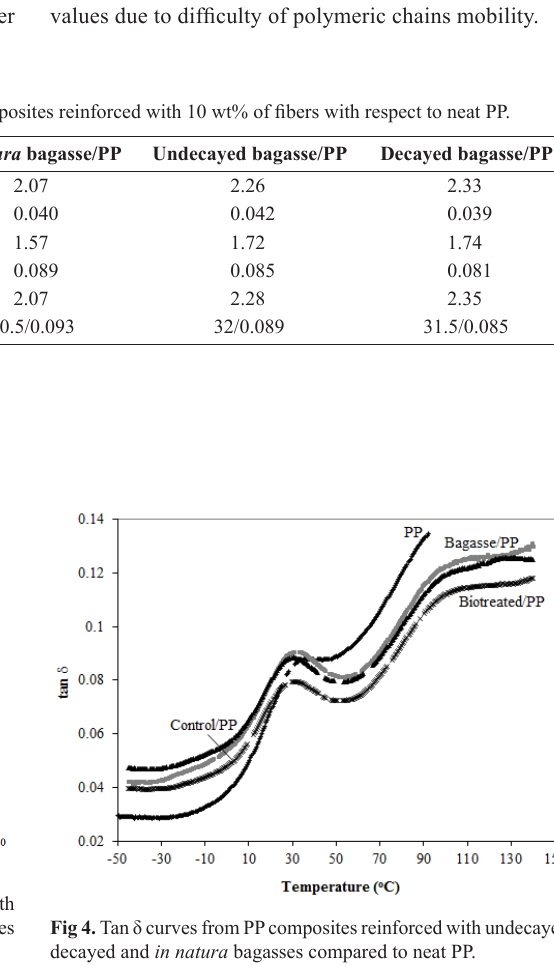
Fig 4. Tan δ curves from PP composites reinforced with undecayed, decayed and in natura bagasses compared to neat